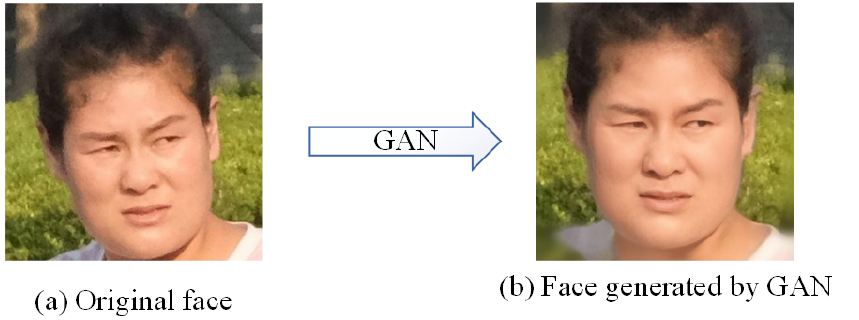
Figure 9. The original face image projected into StyleGAN: ( a ) Original face. ( b ) Face generated by